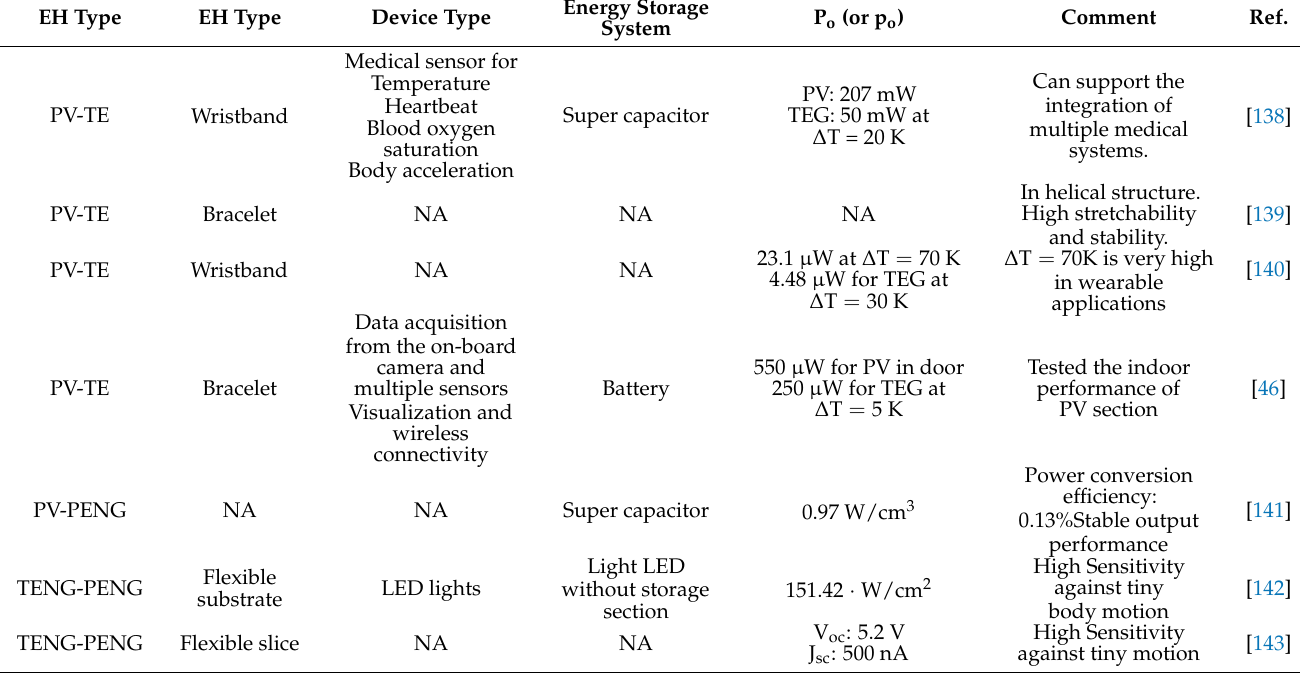
Table 10. Performance of latest flexible hybrid energy harvesting systems.